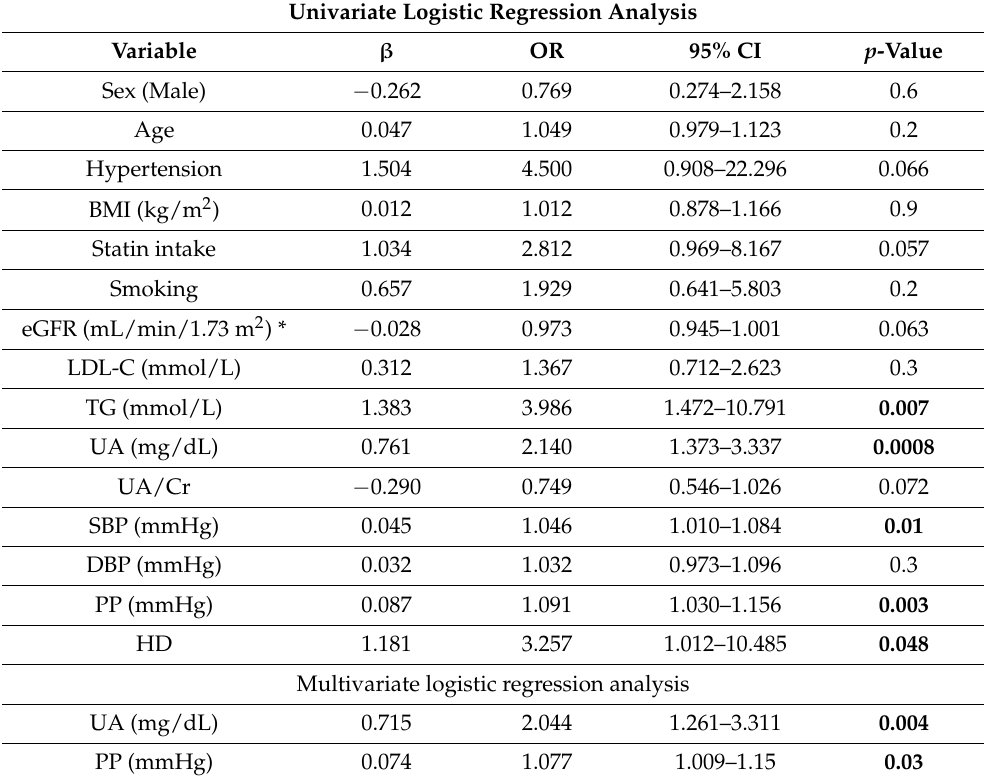
Table 4. Univariate and multivariate logistic regression analyses of factors associated with CAD (N = 63). Univariate Logistic Regression